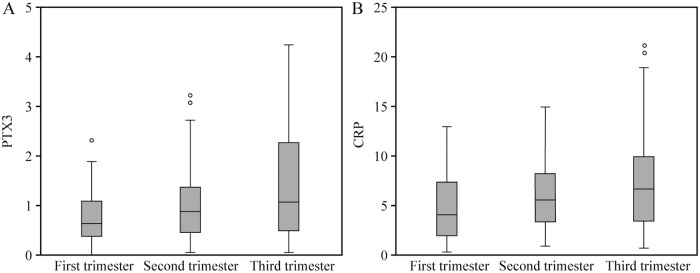
Comparison of serum PTX3 and hs-CRP llevels in different periods of pregnancy.